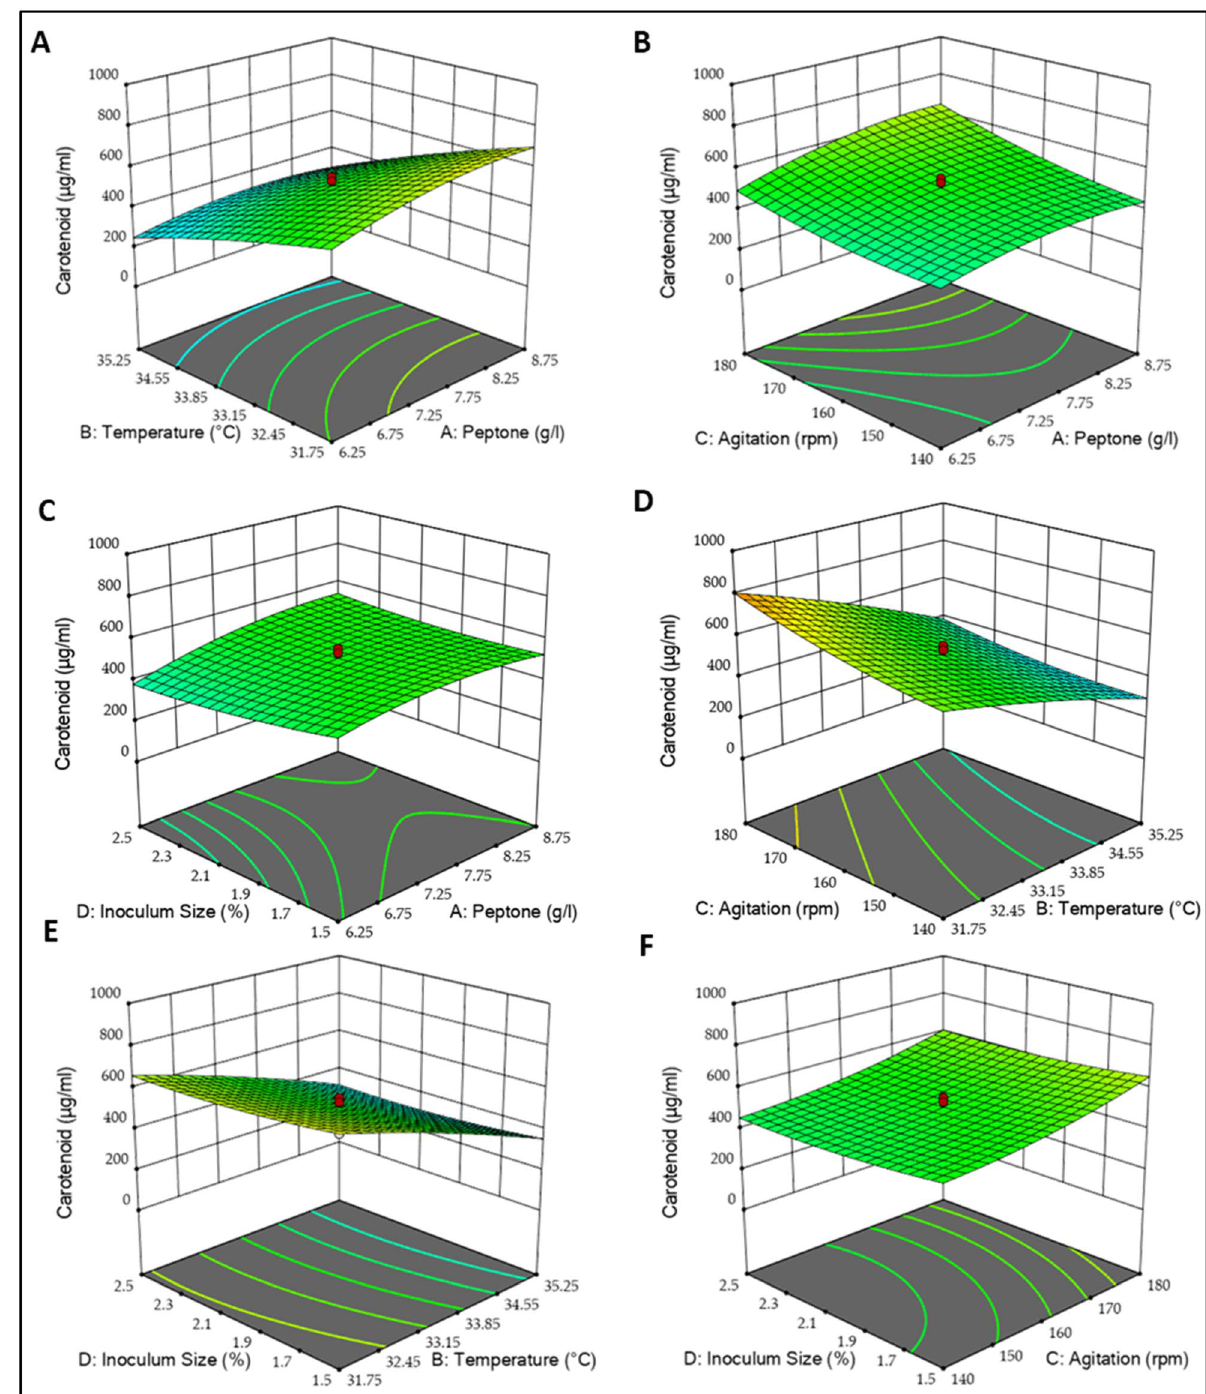
( E ) Inoculum size and temperature interaction, ( F ) Inoculum size and agitation